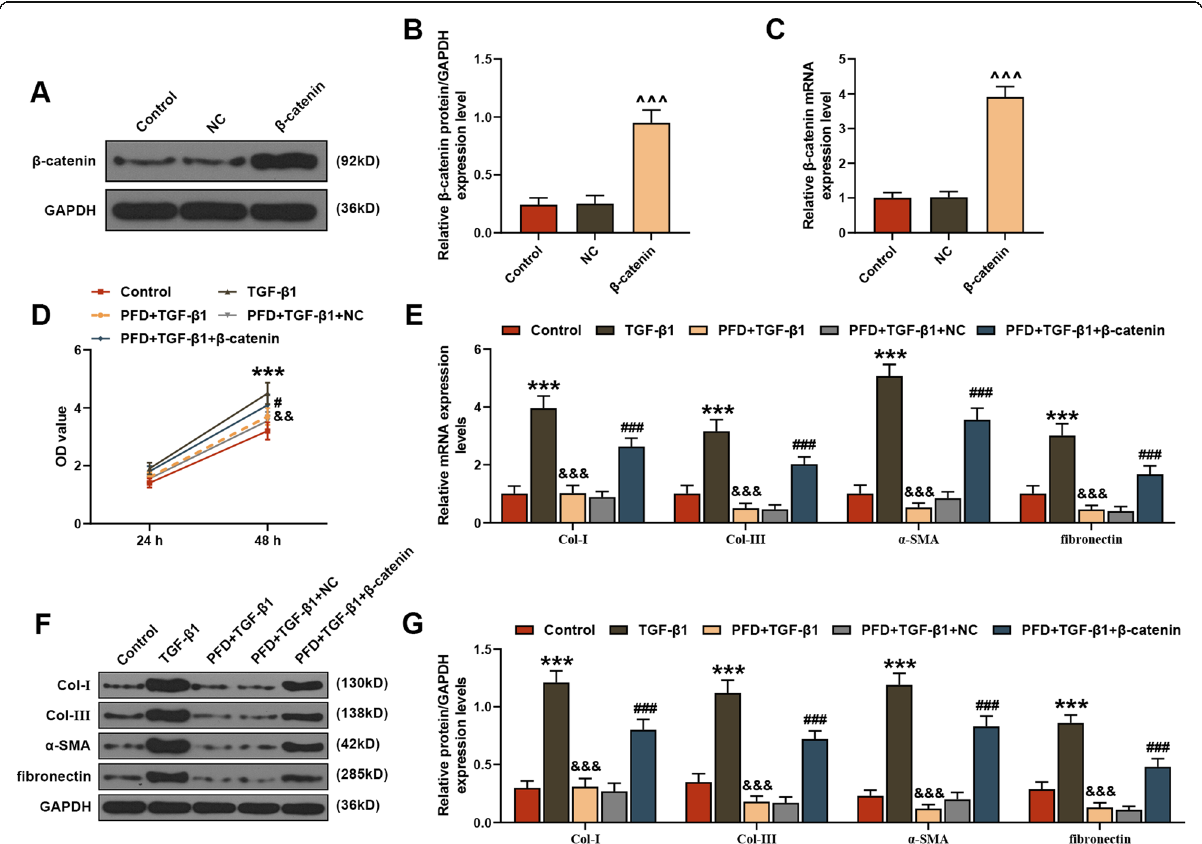
Fig. 3 Pirfenidone (PFD) alleviated the damage of TGF- β 1 to human fetal lung fibroblasts (HLFs). a , b Western blot (WB) and ( c ) quantitative real- time polymerase chain reaction (qRT-PCR) assays were used to measure the mRNA expression levels of β -catenin in HLFs after transfection with negative control (NC) or β -catenin vevtor, and untreated cells acted as controls. In following diagrams, HLFs were divided into control, TGF- β 1, PFD + TGF- β 1, PFD + TGF- β 1 + NC and PFD + TGF- β 1 + β -catenin groups. d The methylthiazolyldiphenyl-tetrazolium bromide (MTT) assay was performed to determine the viability of HLFs after treatment for 24 and 48 h. The mRNA and protein levels of collagen (Col)-I, Col-III, α -SMA and fibronectin in HLFs were determined by ( e ) qRT-PCR and ( f , g ) WB assays. ^^^ P < 0.001, vs. NC; *** P < 0.001, vs. control; &&& P < 0.001, vs. TGF- β 1; ### P < 0.001, vs. PFD + TGF- β 1 + NC. N =